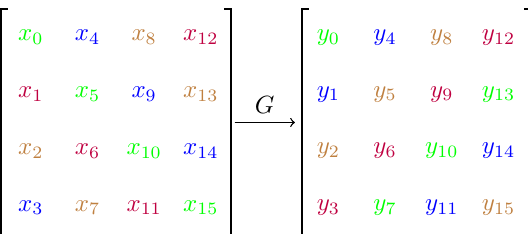
Figure 2: A graphical representation of G given input and output x and y respectively. Input and output of each super-box indicates with a same